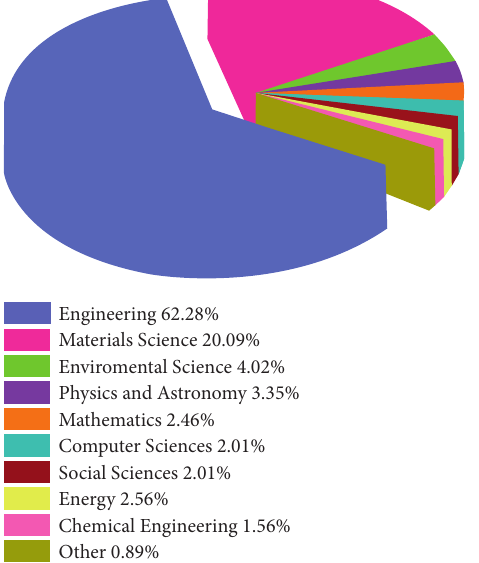
Figure 3: Subject categories of 297 publications on service life prediction of RC structures in the chloride environment.